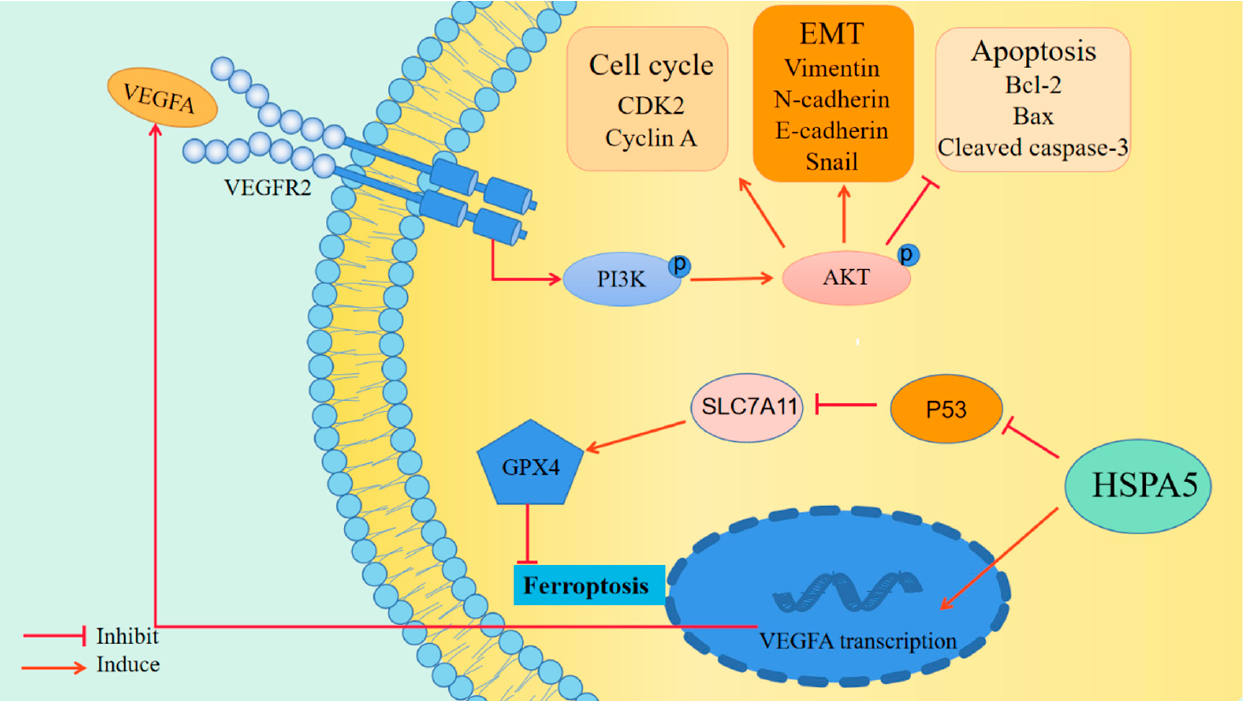
Figure 10. HSPA5 facilitates bladder tumour progression via VEGFA/VEGFR2 pathway and enhances ferroptosis resistance through P53/SLC7A11/GPX4 pathway.